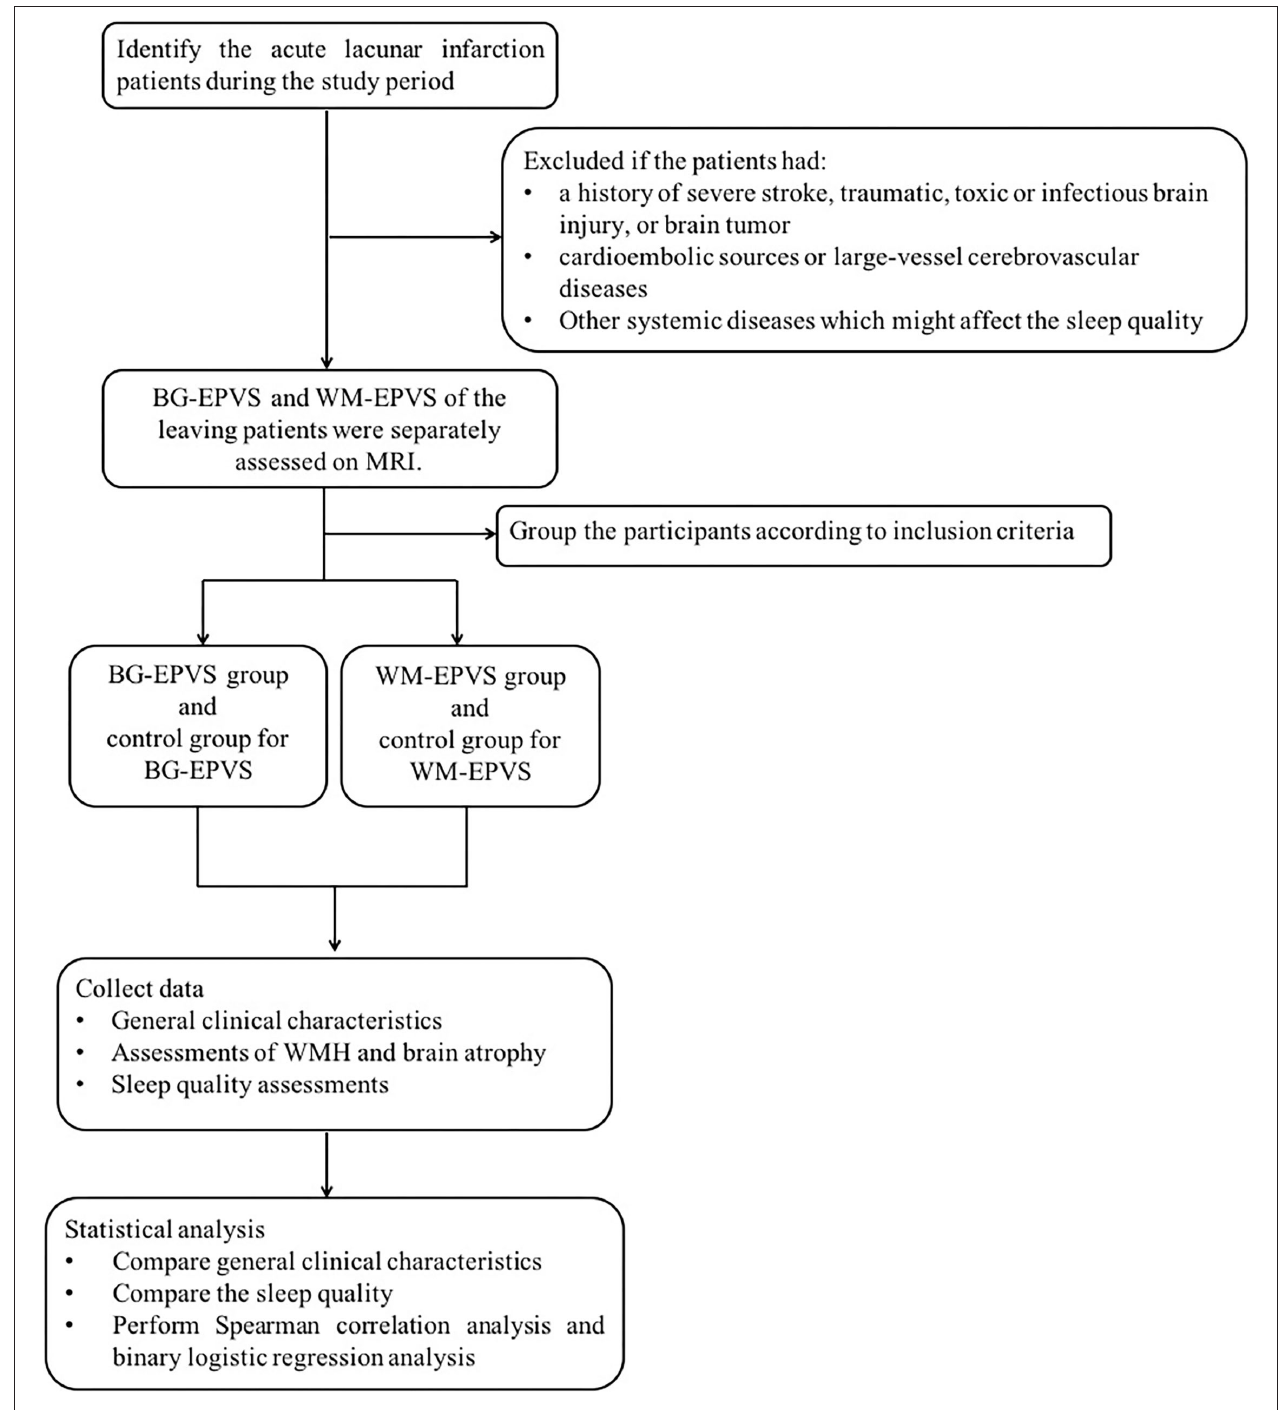
FIGURE 1 | Research flow chart. BG-EPVS, enlarged perivascular spaces in basal ganglia; WM-EPVS, enlarged perivascular spaces in white matter; WMH, white matter hyperintensities.